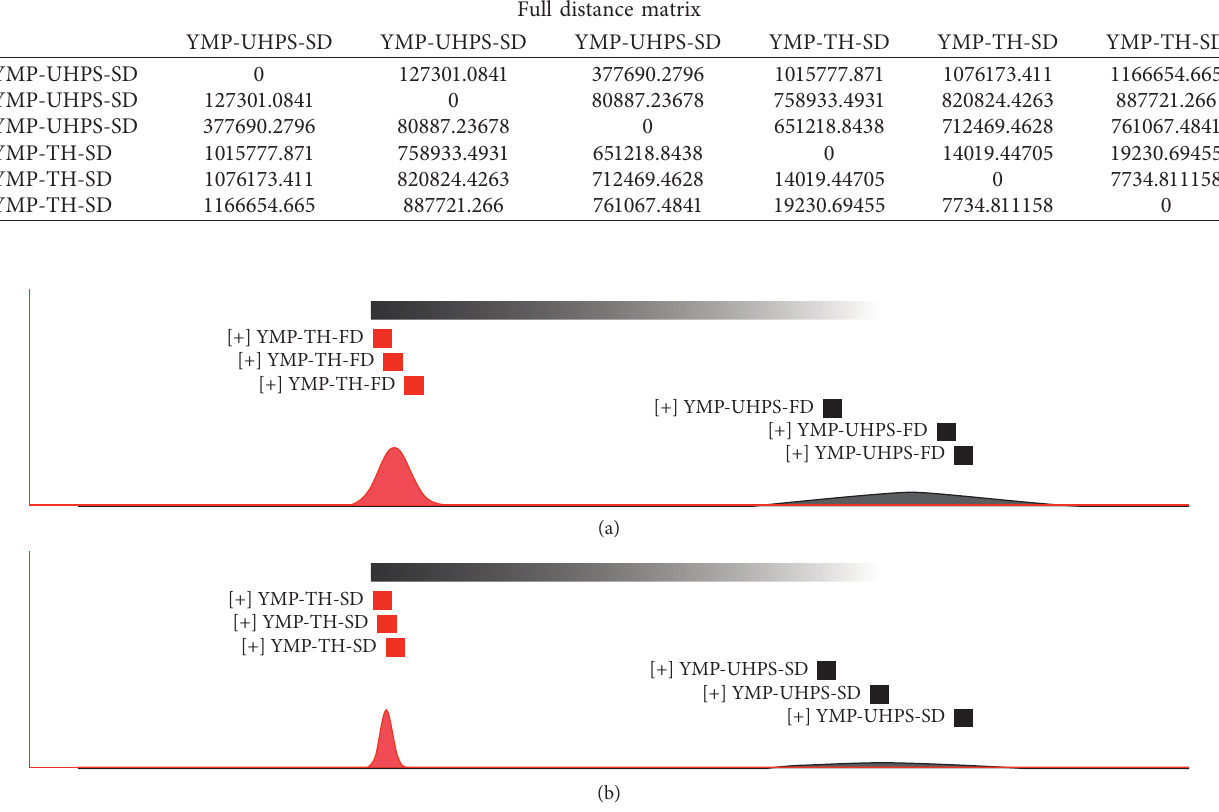
Figure 5: Similarity analysis of fingerprint based on the Euclidean distance of